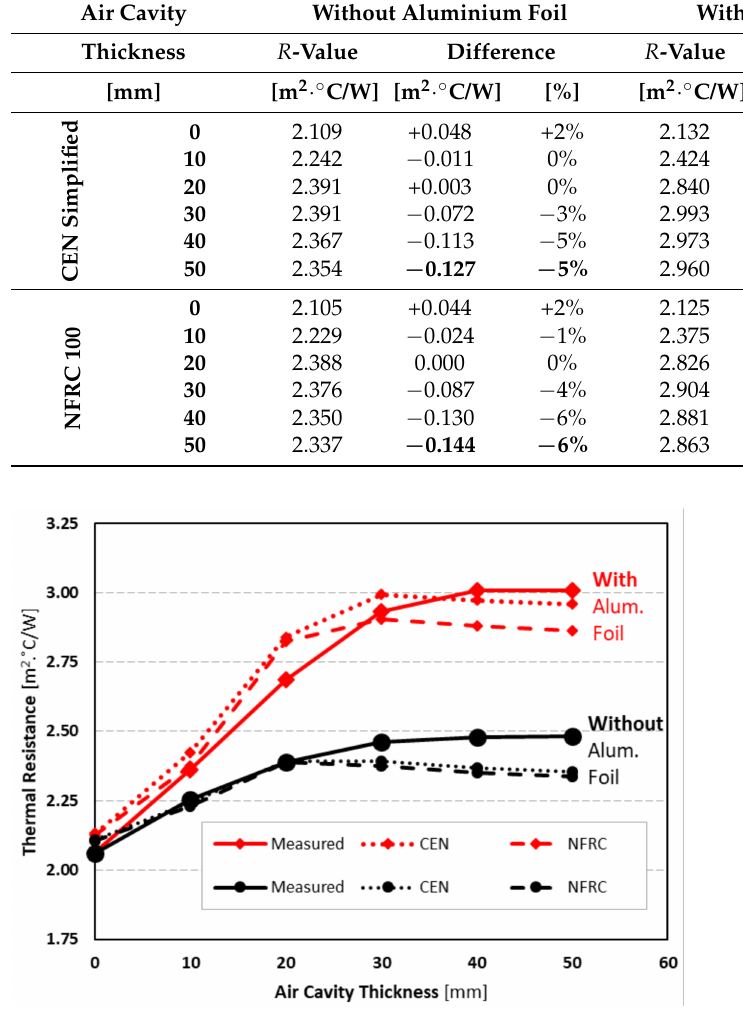
Figure 10. Measured and predicted conductive thermal resistances of a double pane LSF wall, with different air cavity thicknesses, with and without a reflective aluminium